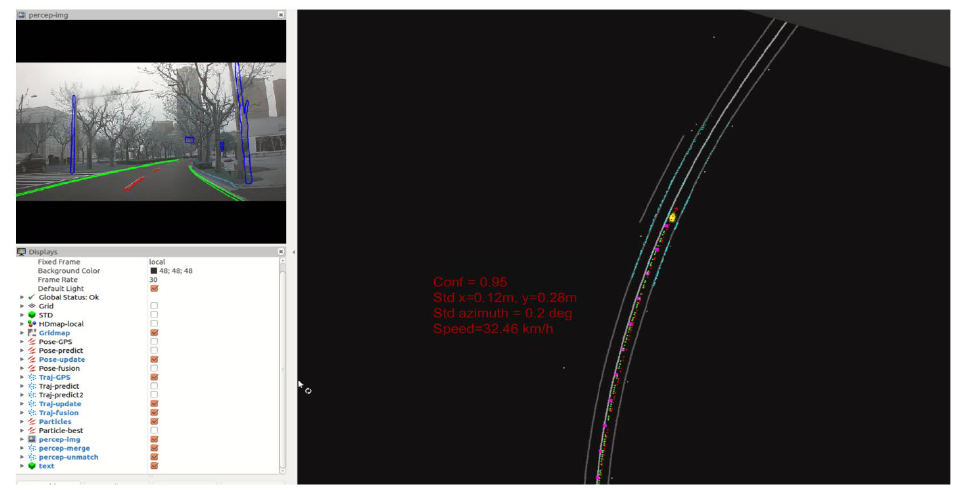
Figure 12. Actual effect picture of fusion positioning based on the crowdsourced map.